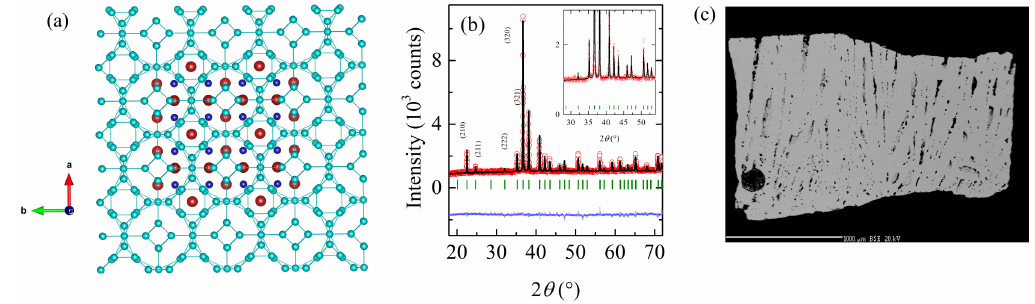
Figure 1. ( a ) The cage-like structural motifs in Sm 3 Co 4 Ge 13 formed by the Ge atoms in the space group Pm 3 n . The Sm (red), Ge (cyan) and Co (blue) atoms are shown. ( b ) The Rietveld refinement results of the PXRD pattern of Sm 3 Co 4 Ge 13 . A few peaks are shown indexed. ( c ) The electron microprobe image obtained from the surface of a polished sample of the compound Sm 3 Co 4 Ge 13 . The scale of magnification is indicated in the figure. Along with the desired phase which accomplished a composition of Sm 3 Co 4.03 Ge 12.96 , only traces of Ge ( < 5 wt%) were observed in the